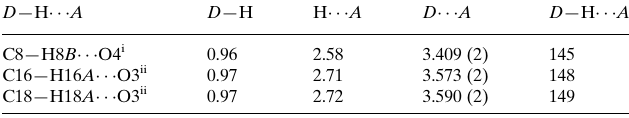
Hydrogen-bond geometry (A˚ , (cid:2)